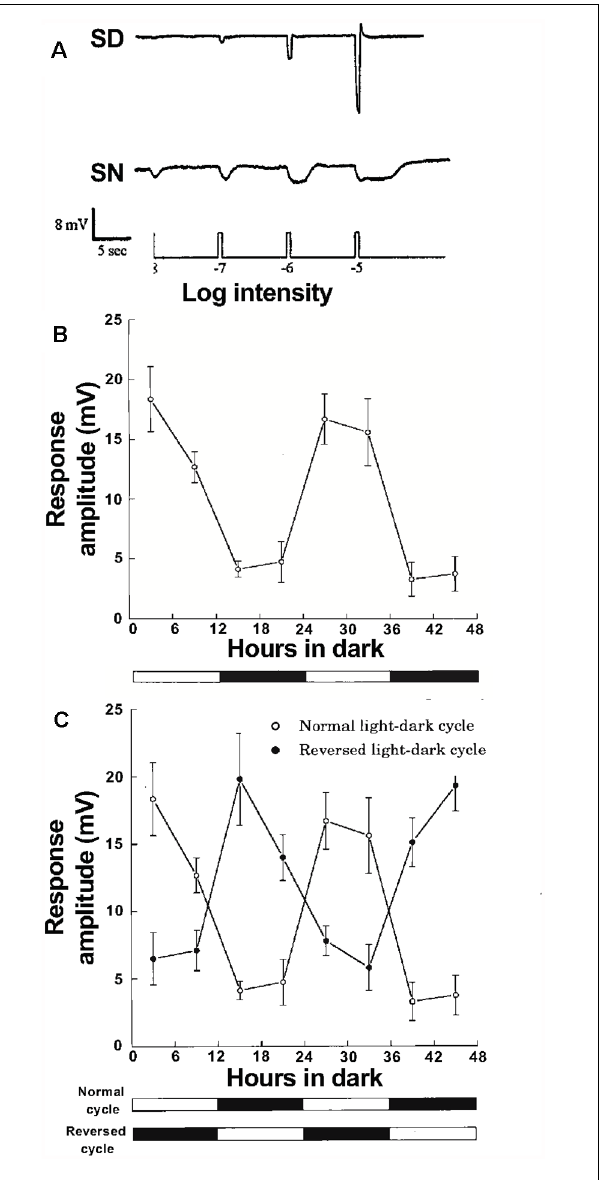
stimuli at night but not in the day due to action of a circadian clock. (A) Responses of L-type cone horizontal (H1) cells to dim full-field white light flashes (ranging from –8 log I o to –5 log I o ) in dark adapted retinas show that cone input to H1 cells dominates during subjective day (SD) and rod input dominates during subjective night (SN). Compared to the day, the responses at night are slower, smaller in size, longer in duration, and response threshold is approximately two log units lower. (B) Average stimulus intensity that generated a threshold (1 mV) response from H1 cells as a function of time in the dark was lower in the subjective night than in the subjective day, indicating that a circadian clock regulates rod input to the cells. (C) Following reversal of the light/dark cycle for 10 days before each experiment, average threshold responses reversed as well, i.e., threshold was approximately two log units lower in the subjective night (which before reversal was the daytime) than in the subjective day. (A–C) Cells were recorded with intracellular micropipettes. Impalement was achieved in complete darkness, except for the use of flashing dim ( < − 6 log I o ) lights to confirm that impalement had ( Continued